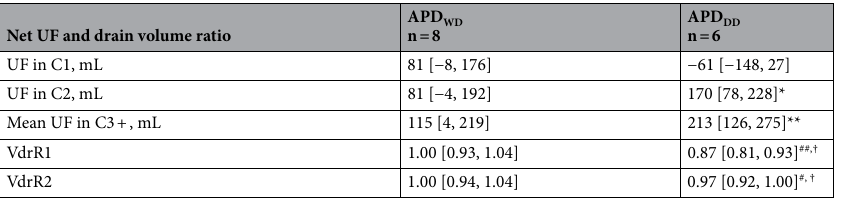
Table 4. Net peritoneal ultrafiltration (UF, median [Q 1 , Q 3 ]) measured for cycle 1 (C1), cycle 2 (C2) and for the mean value from cycle 3 and following cycles (C3 +), as well as the ratio of drain volumes calculated for first (VdrR1) and second (VdrR2) cycle over a mean value for C3 + for patients undergoing APD WD and APD